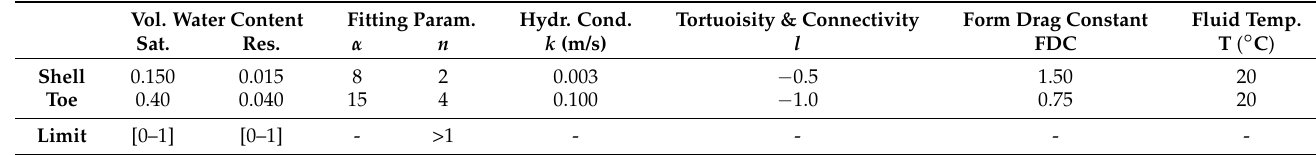
Table 3. Summary of numerical model parameters.